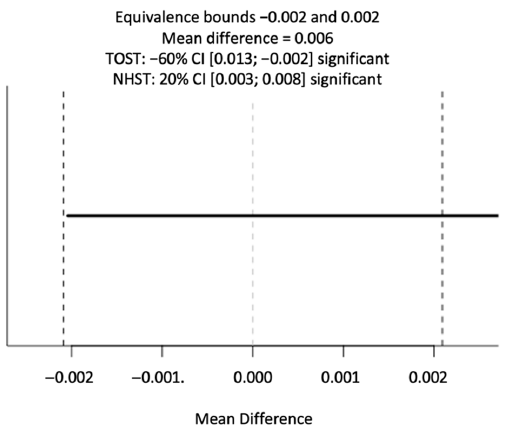
Figure 5. Results of the Independent Groups Student’s Equivalence test. The horizontal line indicates the confidence interval of the two one-sided t -test procedure, dotted vertical lines indicate equivalence bounds.